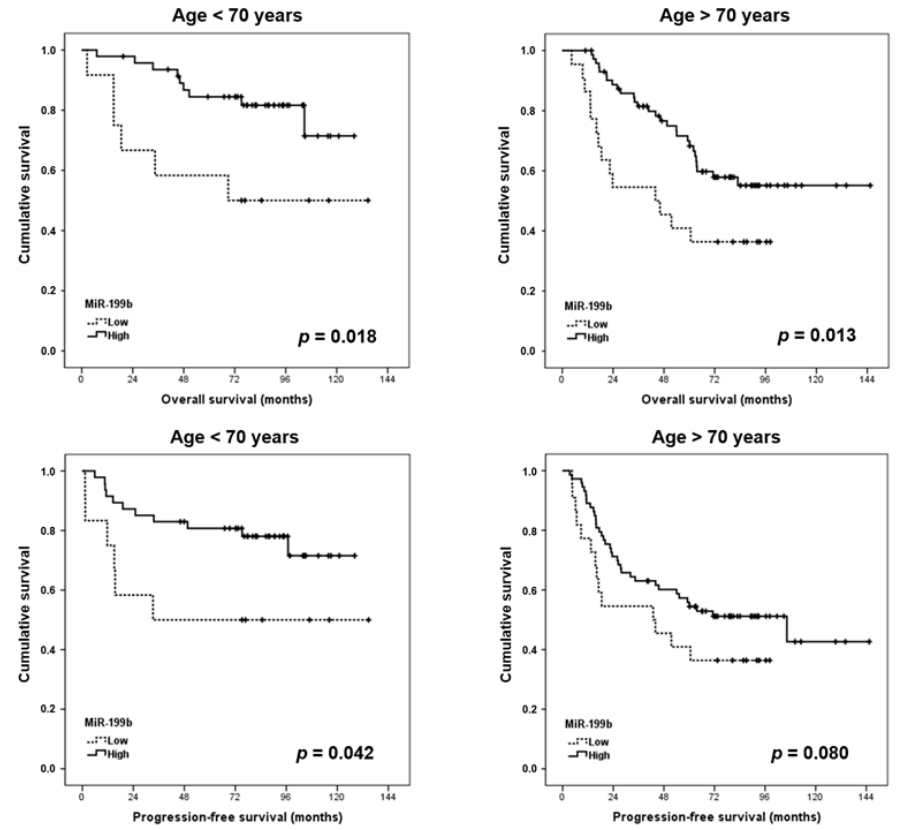
Figure 2. Kaplan–Meier analyses for miR-199b in the cohort of 157 early-stage CRC patients stratified by age.